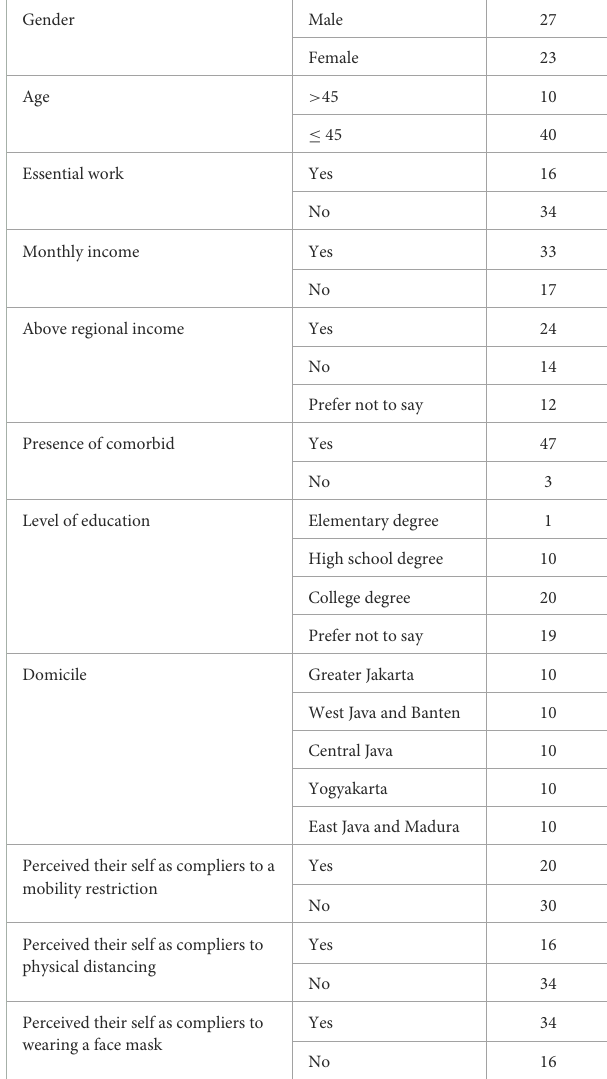
TABLE 1 Characteristics of the